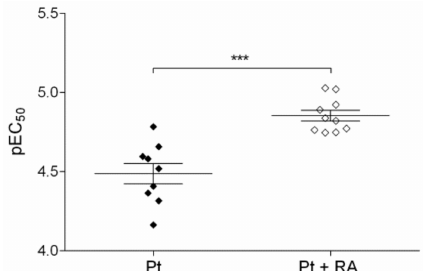
Figure 9. Sensitivity of SKOV-3 cells (pEC 50 , mean ± SEM, n = 9–10) of cisplatin alone (Pt), and upon co-incubation with 20 µ M retinoic acid (Pt + RA) was determined over 48 h. *** p <